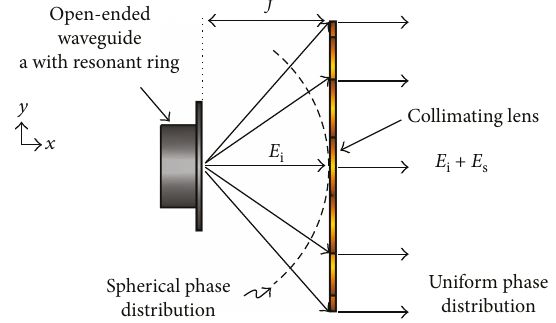
Figure 2: Schematic view of the proposed single layer lens